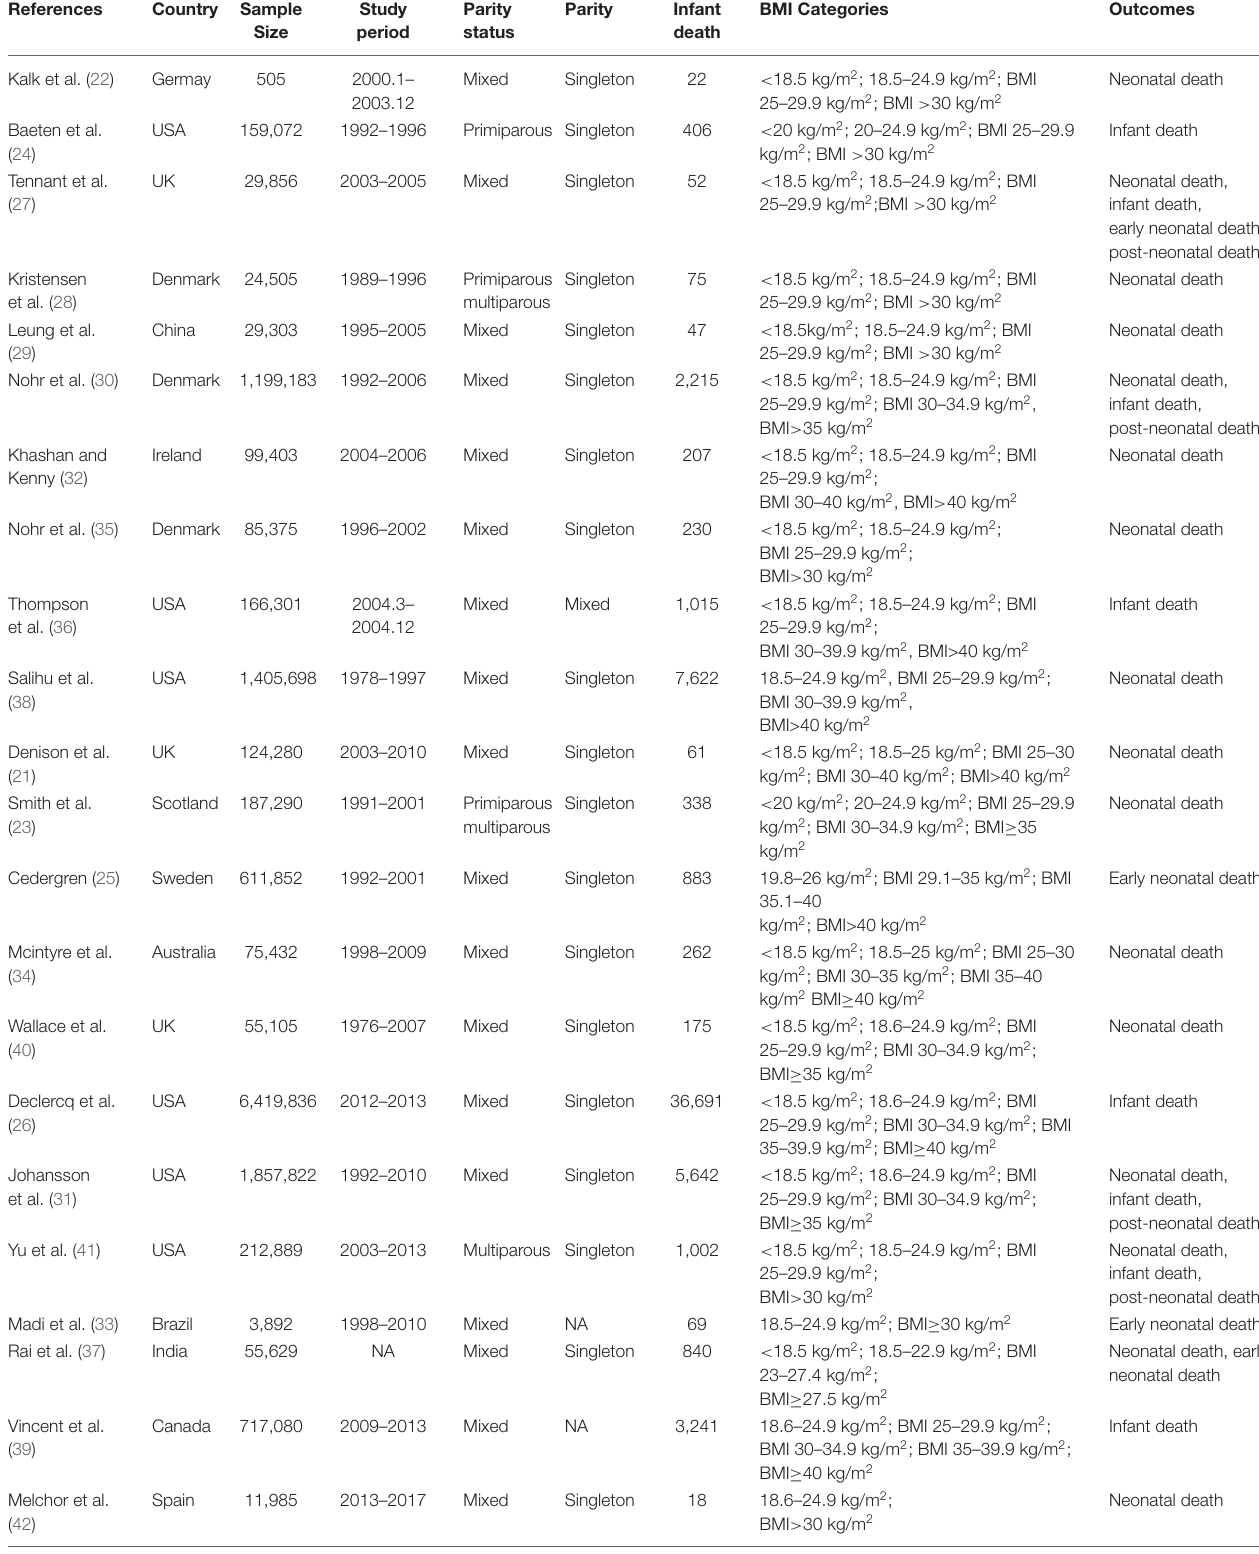
TABLE 1 | The detailed baseline characteristics of the 22 cohort